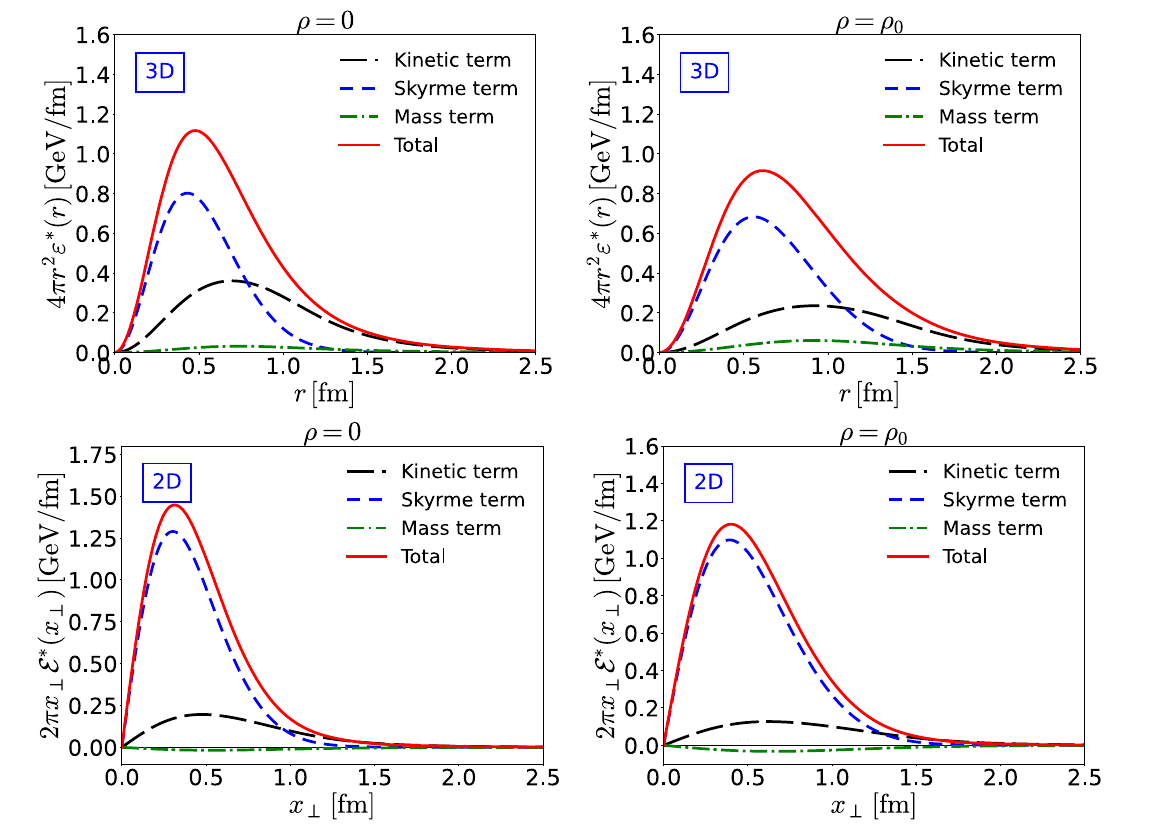
Fig. 2 The 3D and 2D mass distributions multiplied respectively by 4 π r 2 and 2 π x ⊥ . The upper-left (-right) panel depicts 3D mass distri- butions with 4 π r 2 at ρ = 0 ( ρ = ρ 0 ). The long-dashed, short-dashed, dot-dashed, and solid curves illustrate the contributions of the kinetic